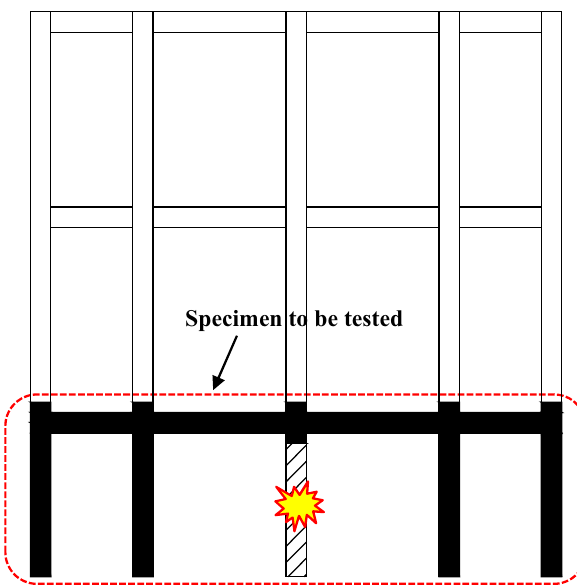
Figure 1: Relationship of the test specimen with a